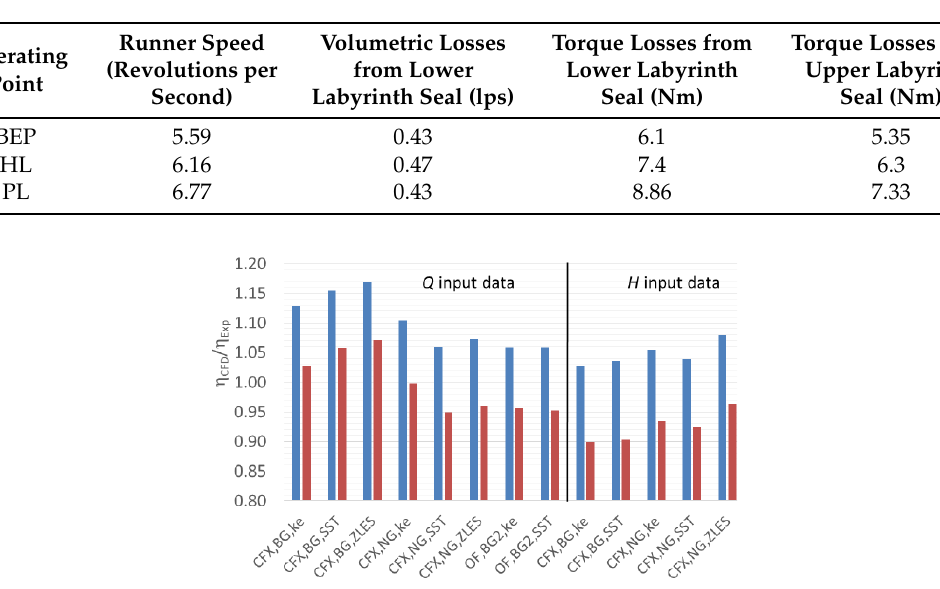
Figure 22. Determination of hydraulic efficiency with and without losses from labyrinth seals under part load operating condition for the model Francis turbine [11]; NG ‐ new grid with approximately 14 million nodes, BG ‐ basic grid with approximately 12 million nodes, OF ‐ OpenFOAM; red bars in the plot indicate the hydraulic efficiency with losses from labyrinth seals.